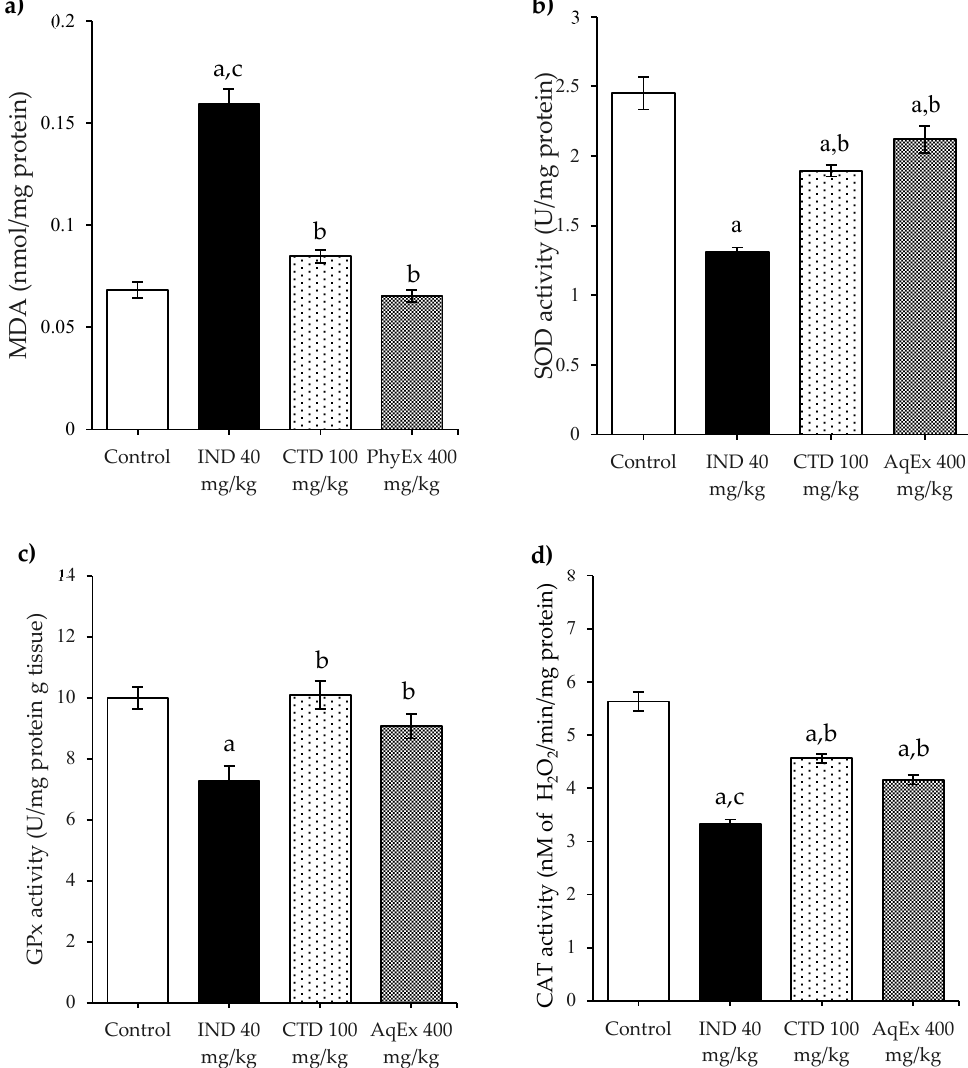
Figure 4. Effects on the content of MDA ( a ), and the activity of SOD ( b ), GPx ( c ), and CAT ( d ) enzymes, after pretreatments with PhyEx and CTD in the gastric ulcer model induced by IND. PhyEx, aqueous extract; CTD, cimetidine; IND, indomethacin. Data are expressed as the mean ± SEM ( n = 6). One-way ANOVA post hoc Student–Newman–Keuls showed a significant difference ( p < 0.01). Literals indicate differences vs. groups: a Control; b IND 40 mg/kg; c PhyEx 400